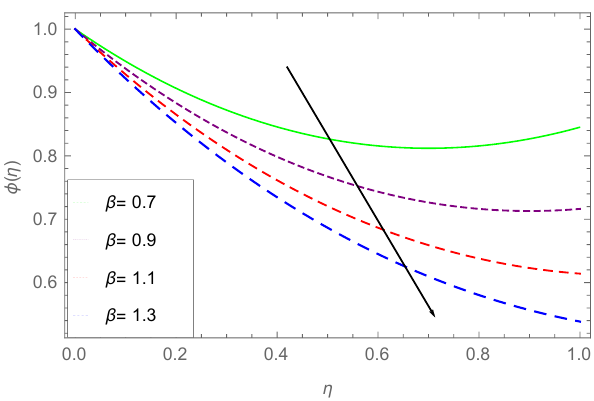
Figure 16. Impact of β on φ ( η ) , when S = 0.7, (cid:101) = 0.8, Sc = 0.9, Pr = 0.6, Nb = 0.8, Nt =